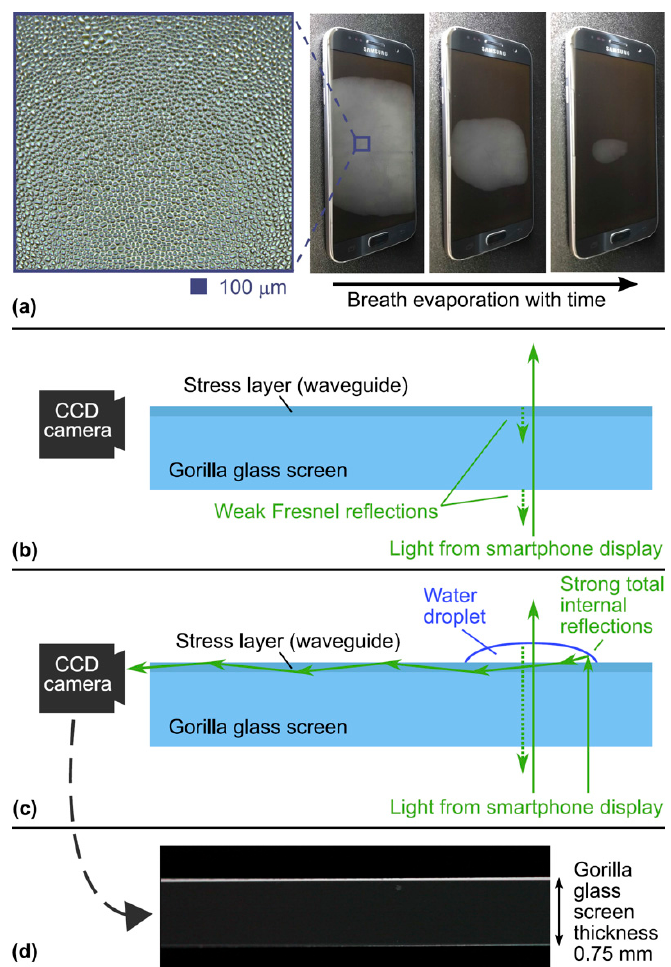
Figure 1. The optical breathalyzer principle. ( a ) Evaporation of the microdroplets when a person breathes on a glass screen. The inset is a zoom on the microdroplets. ( b ) The light from the smartphone display is not coupled to the planar waveguide on the surface of the glass screen. ( c ) With water droplets on the glass screen, the light from smartphone display is coupled to the planar waveguide, due to the strong oblique reflections at the edge of the droplets, and is guided to the side of the screen. ( d ) Photograph of the guided light in ( c ) using a CCD camera and a 10× objective lens.